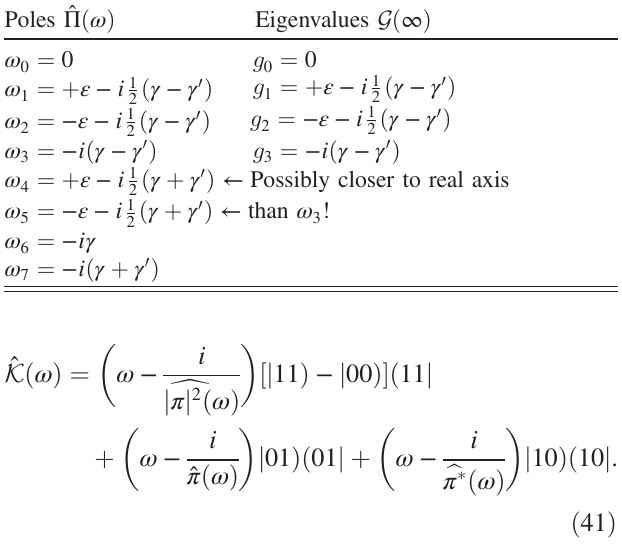
TABLE I. Jaynes-Cummings model. Poles of